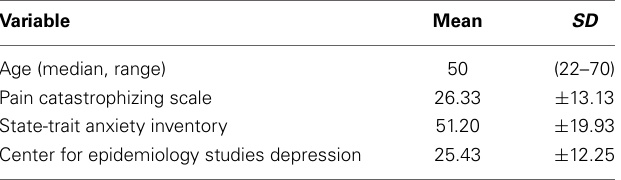
Table 1 | Demographic information.